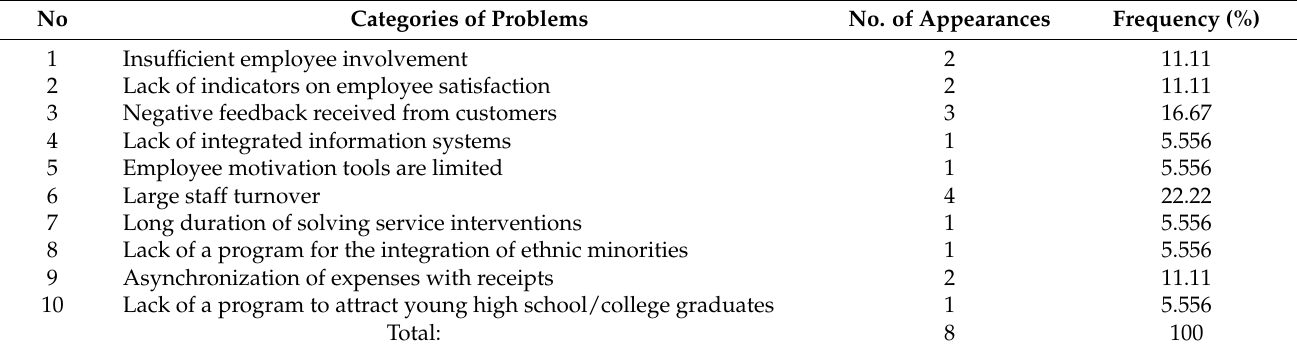
Table 9. Answers collected regarding the questions related to Hypothesis